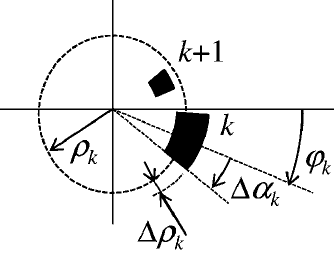
FIG. 6. Definition of the geometric parameters for a rotating coil.